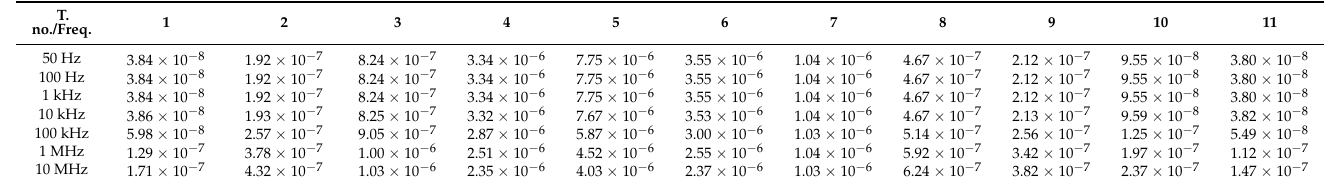
Table A4. Self and mutual inductances of turn 11 (in H) resulting from FEM simulations. T. no./Freq.